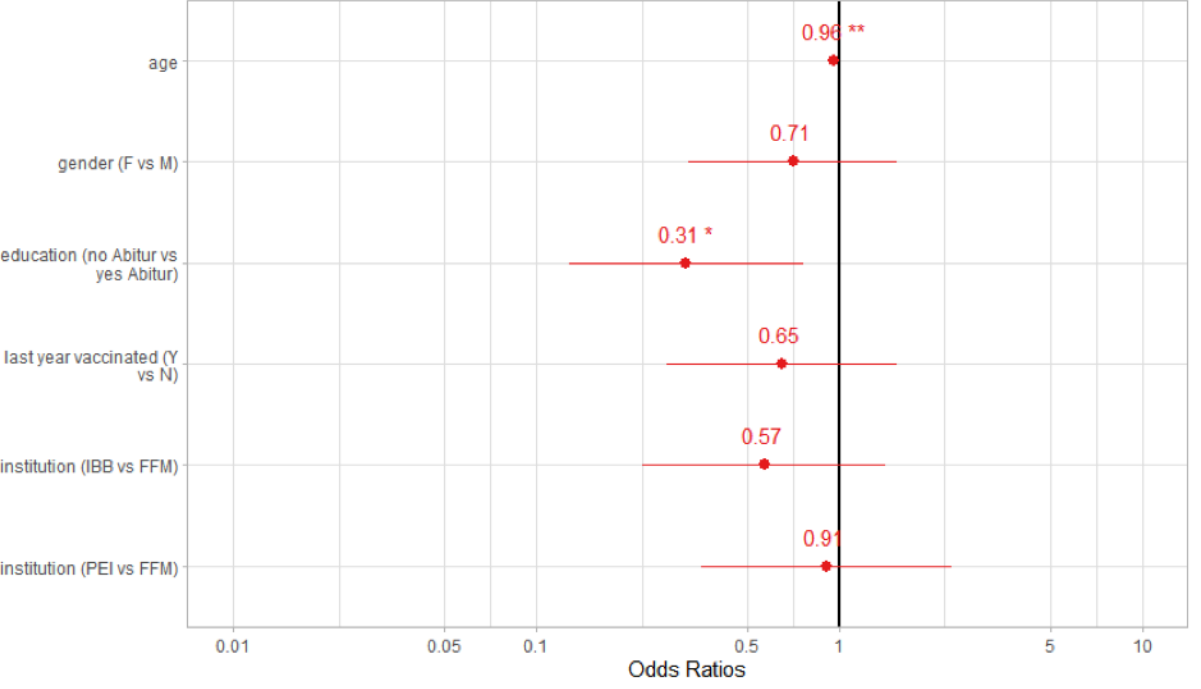
Figure 5. Factors associated with correct versus incorrect entry of vaccination information, pseudoR2 (McFadden) = 0.124. F: female; M; male; Y: yes; N: no; IBB: Investitionsbank Berlin; FFM: University Hospital Frankfurt; PEI: Paul Ehrlich